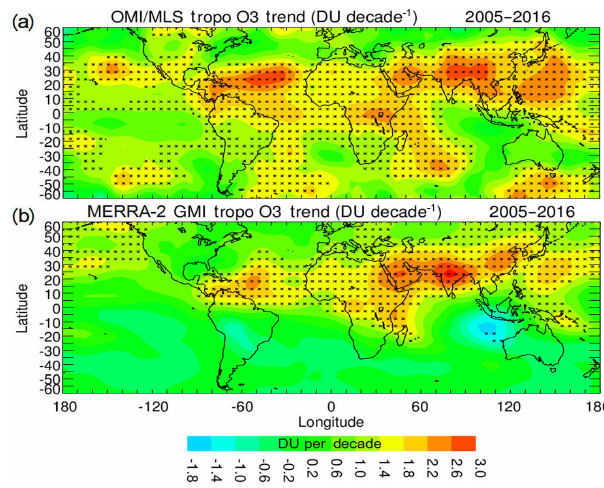
Figure 1. (a) Trends in OMI/MLS TCO (in DUdecade − 1 ) for 2005–2016. Asterisks denote grid points where trends are statisti- cally significant at the 2 σ level. (b) Same as (a) except for MERRA- 2 GMI TCO.